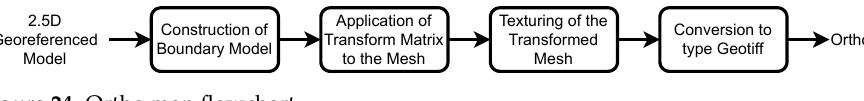
Figure 24. Ortho map